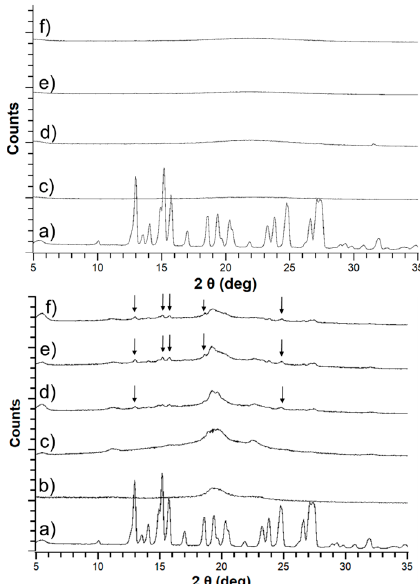
Figure 4. Powder X-ray (PXRD) patterns for carbamazepine loaded silica (top) and carbamazepine HME (bottom) showing crystalline carbamazepine (a), pure Parteck MXP ® (PVA) (b), unstressed carbamazepine formulation (c) and stressed carbamazepine formulations at 30 (d), 60 (e), and 90 (f) days. The arrows indicate crystalline peaks in the diffractograms.